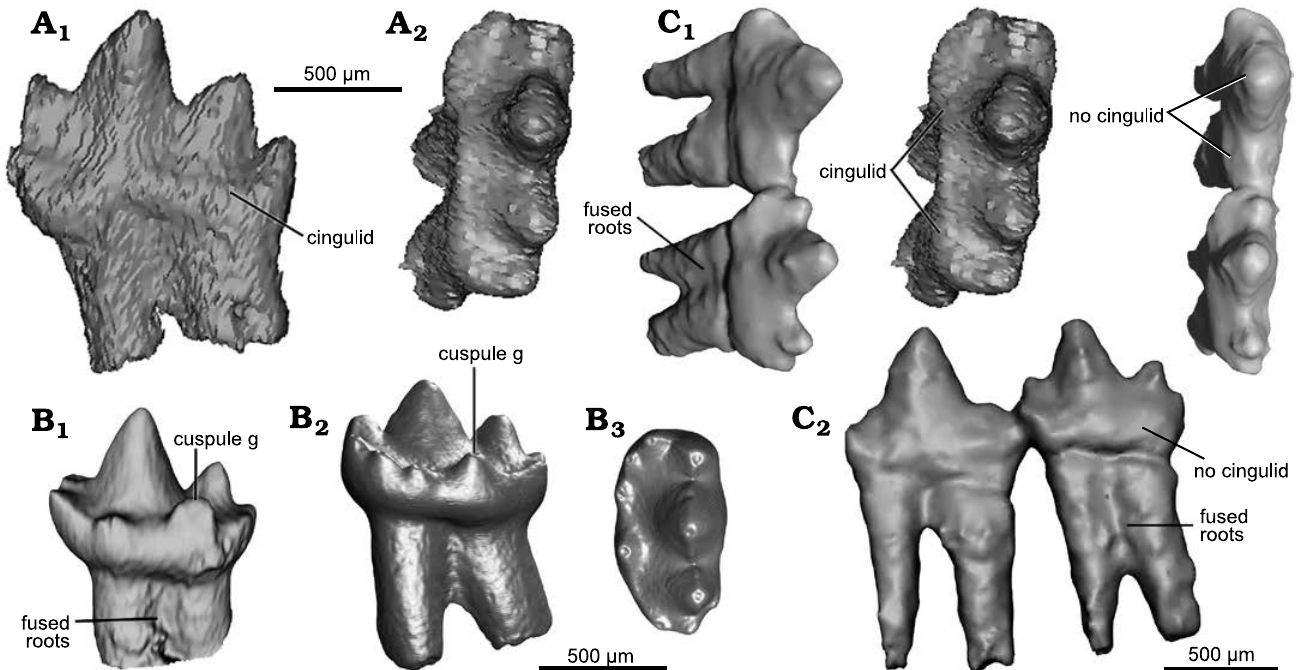
Fig. 10. Comparative morphology of lower molars of Hadrocodium and Morganucodon . A . The morganucodontan Morganucodon oehleri Rigney, 1963, from the Lower Lufeng Formation, Lower Jurassic of China. BMNH 2858, ultimate lower molar (right m4) lingual (A 1 ) and oblique occlusal (A 2 , ste- reopairs) views. B . The morganucodontan Morganucodon watsoni Kühne, 1949, from the Lower Jurassic fissure fills of Wales. UMZC Eo.CR1, ultimate molar (m4); lingual view (B 1 ) (Jäger et al. 2019, image courtesy of Kai Jäger), lingual (B 2 ) and occlusal (B 3 ) views (Gill et al. 2014, images courtesy of Pamela Gill). C . The mammaliaform Hadrocodium wui Luo, Crompton, and Sun, 2001, from the Lower Lufeng Formation, Lower Jurassic of Yunnan, China. Holotype, IVPP 8275, right m1 and m2 in occlusal (C 1 , stereopairs) and lingual (C 2 )